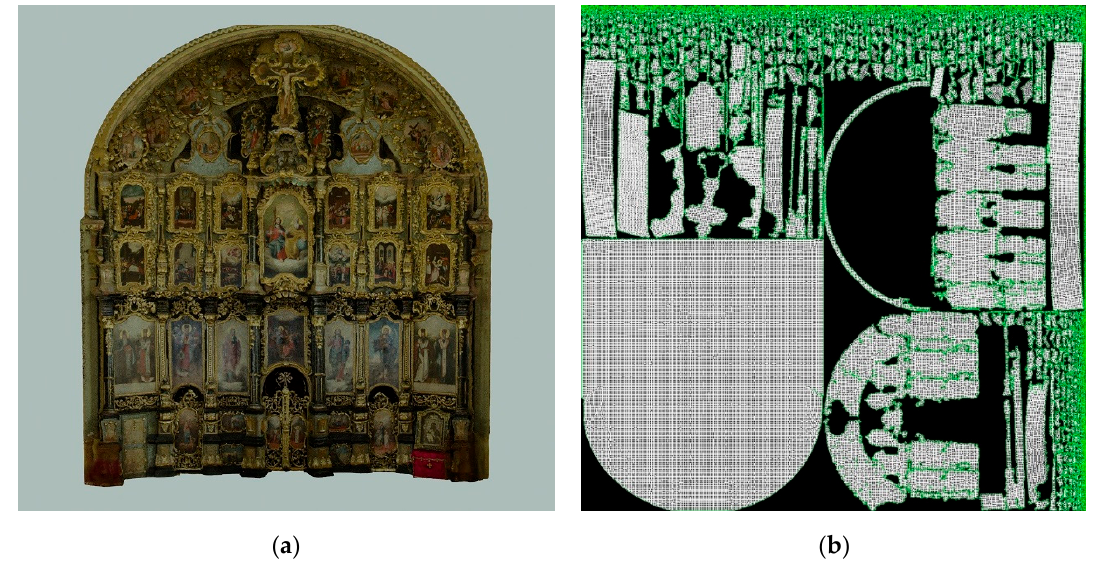
Figure 8. ( a ) Textured low poly model in 3ds Max; ( b ) UV map in 3ds Max.